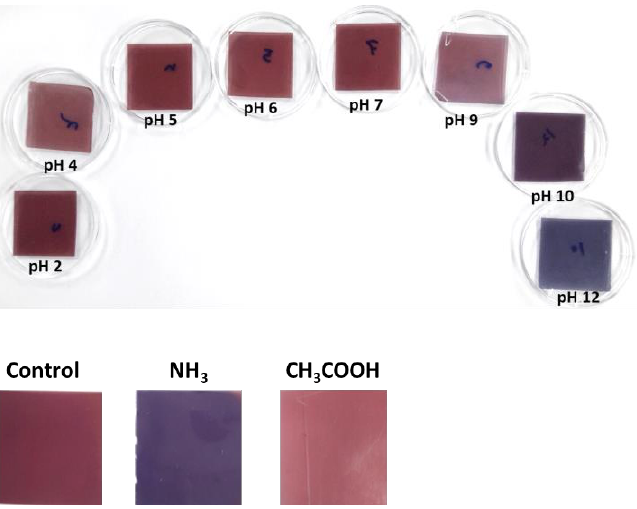
Figure 1. pH-responsive color change of the indicator film and volatile gas sensitivity of the